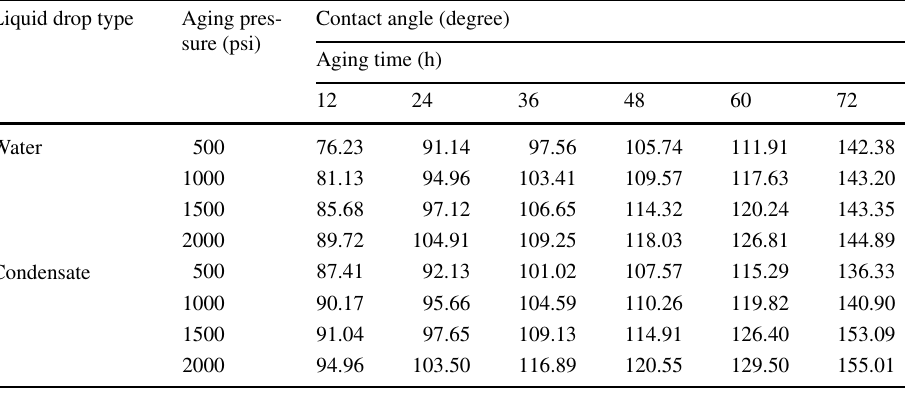
information from contact angle tests from placing the water and condensate drops in the presence of the air on aged carbonate sections in R404A gas at 70 °C and different pressures of aging